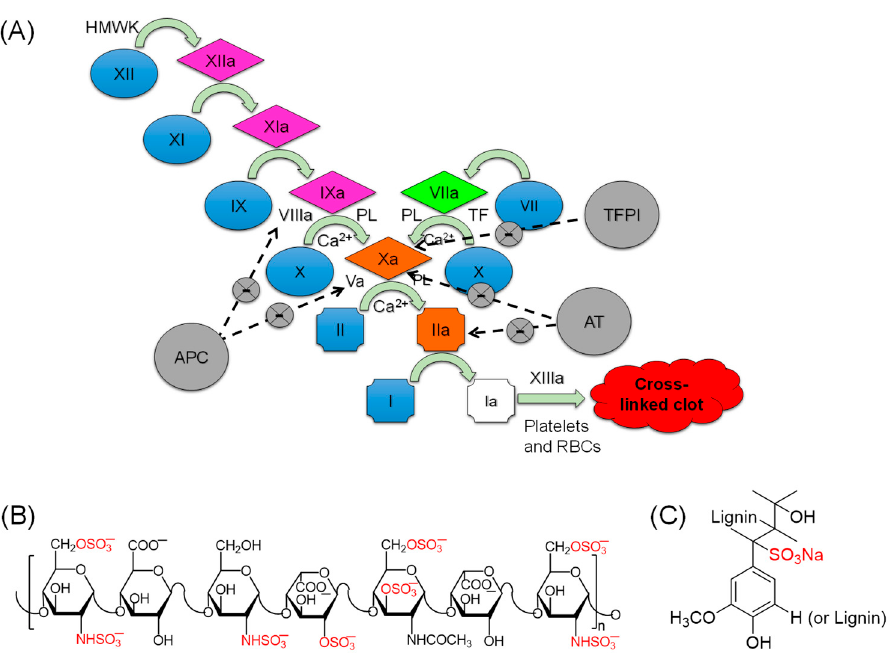
Figure 1. ( A ) A waterfall representation of the coagulation cascade in which the serine proteases of the intrinsic pathway (FXIIa, FXIa, and FIXa), the extrinsic pathway (FVIIa), and the common pathway (thrombin and FXa) work in a cascade fashion to form a clot that subsequently gets rigidified by FXIIIa-mediated fibrin cross linking. ( B ) A representative chemical structure of heparins, a mixture of linear polysaccharides that are largely decorated with negative charge (sulfate and carboxylate). The sulfate groups represent the fundamental structural requirements needed for heparins to act as anticoagulants via activating endogenous AT. ( C ) A representative structure of lignosulfonic acid sodium (LSAS) polymer that is proposed in this study as a platform to develop alternatives to heparins for use as clinically relevant and safe anticoagulants by targeting proteins in the intrinsic pathway of coagulation. High molecular weight kininogen (HMWK), phospholipid (PL), tissue factor pathway inhibitor (TFPT), antithrombin (AT), activated protein C (APC), red blood cells (RBCs).